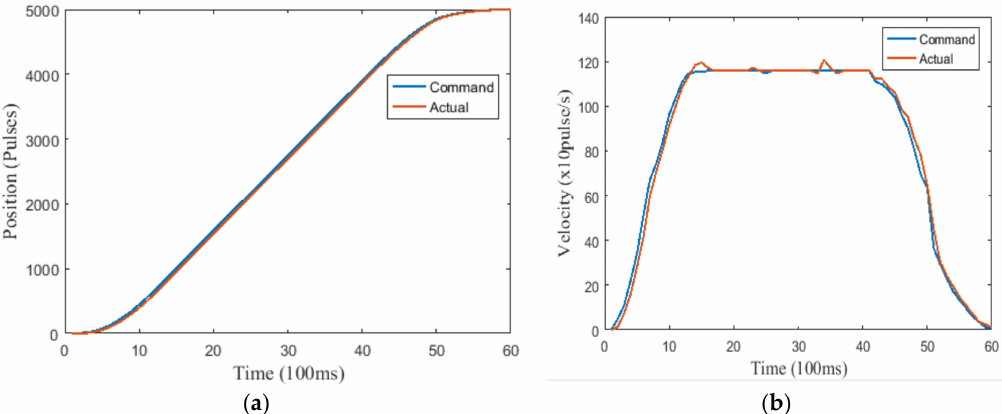
Figure 23. Comparison between the command and actual results using the motion profile in the open